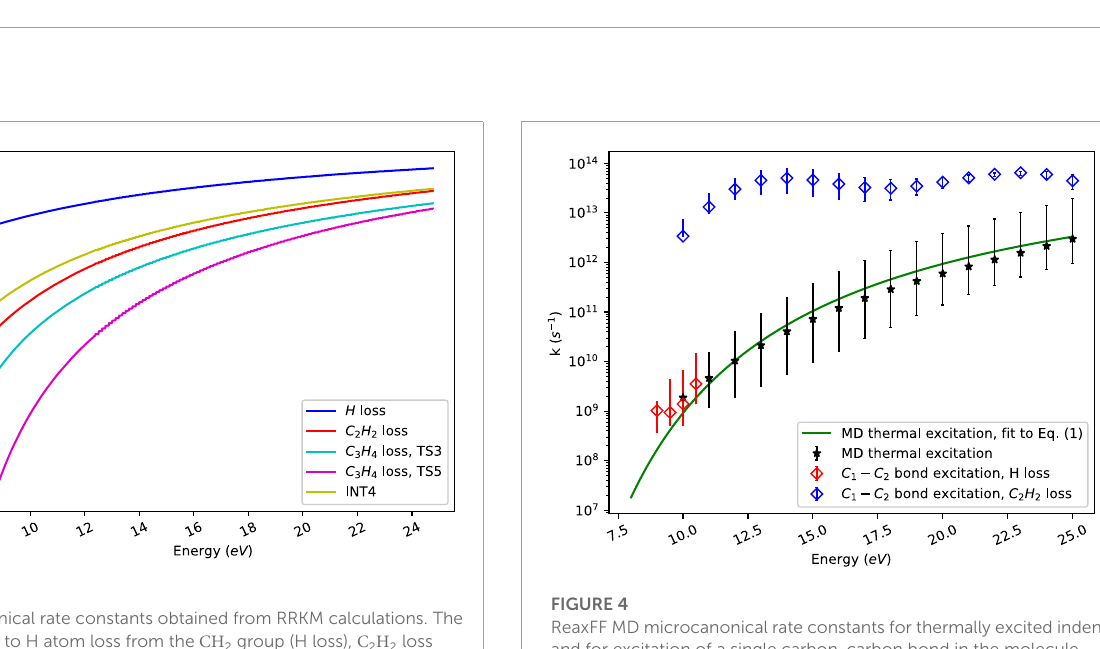
FIGURE 2 Potential energy profile obtained for indene decomposition at CBS-QB3 level of theory. Zero-point energy is included. The structures of indene and the intermediates are shown with the carbon atoms numbered as in Figure 1 .